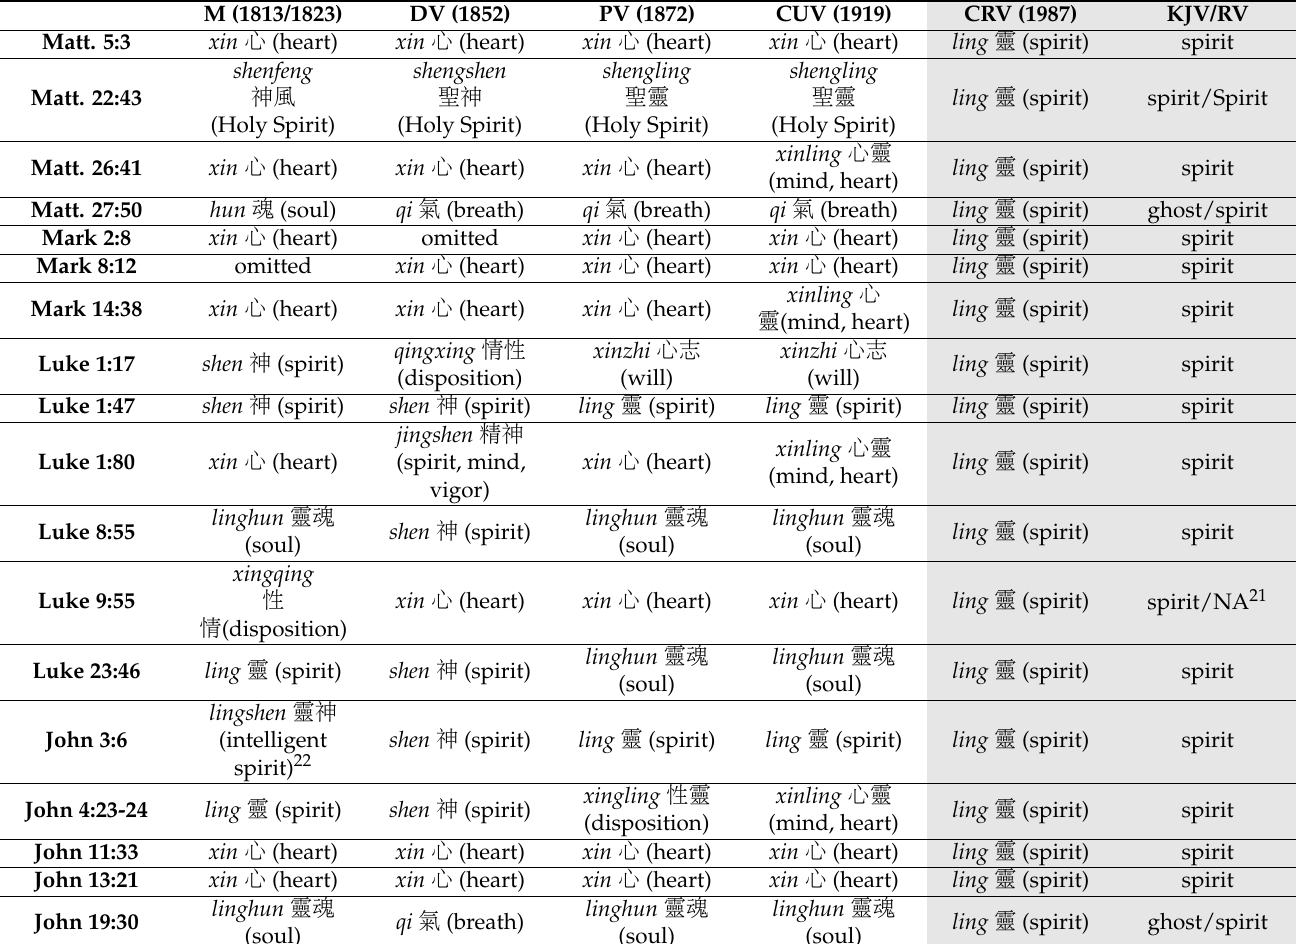
Table 1. The translation of pneuma (spirit) in the four